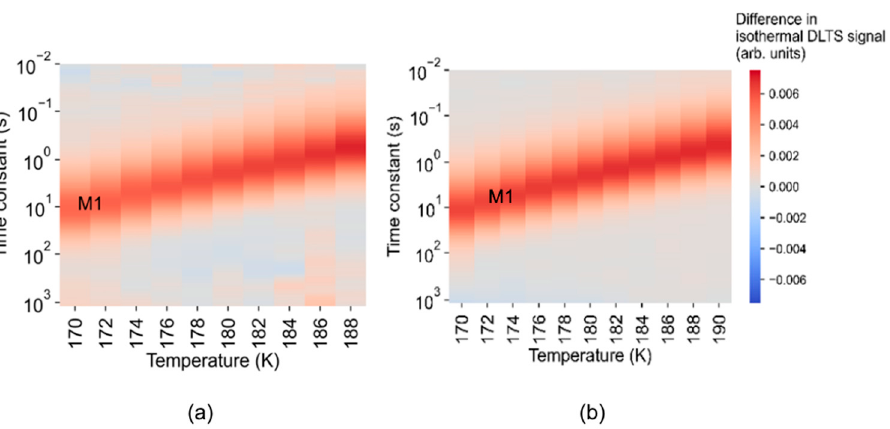
Figure 6. Heatmap plots of differential isothermal DLTS signals for ( a ) neutron-irradiated and ( b ) ion-implanted 4H-SiC samples.